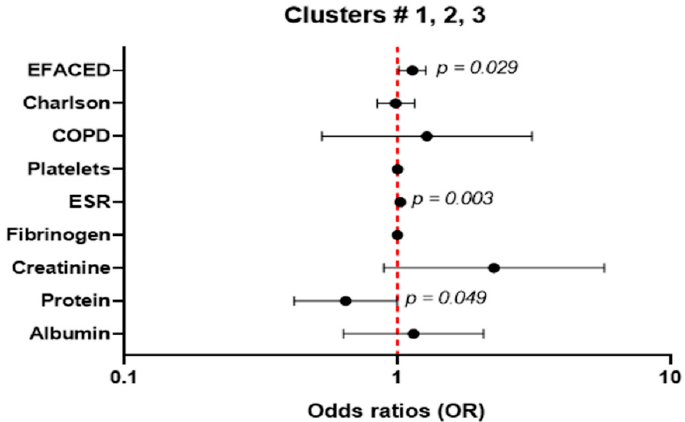
Figure 8. Multivariate ordinal logistic regression, in which the outcome variable was clusters (ordered from 1, the lowest level, to 3, the highest level) was used to assess the potential associations of